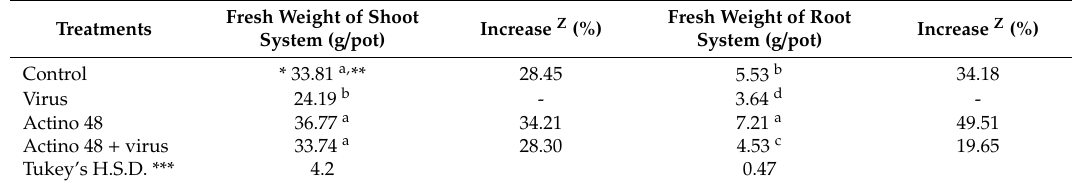
Table 3. Effect of treatment with a cell pellet suspension of Streptomyces cellulosae Actino 48 on the fresh weights of shoot and root systems in tomato plants inoculated with tobacco mosaic virus.